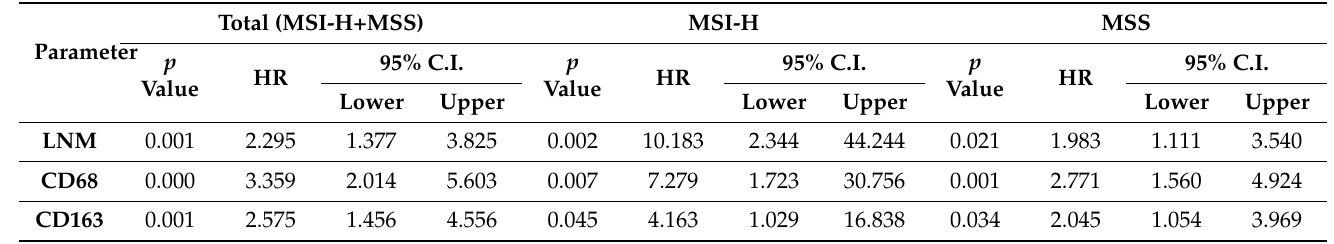
Table 2. Multivariate logistic regression analysis according to EMR1-TC (low vs. high) in MSI-H and MSS